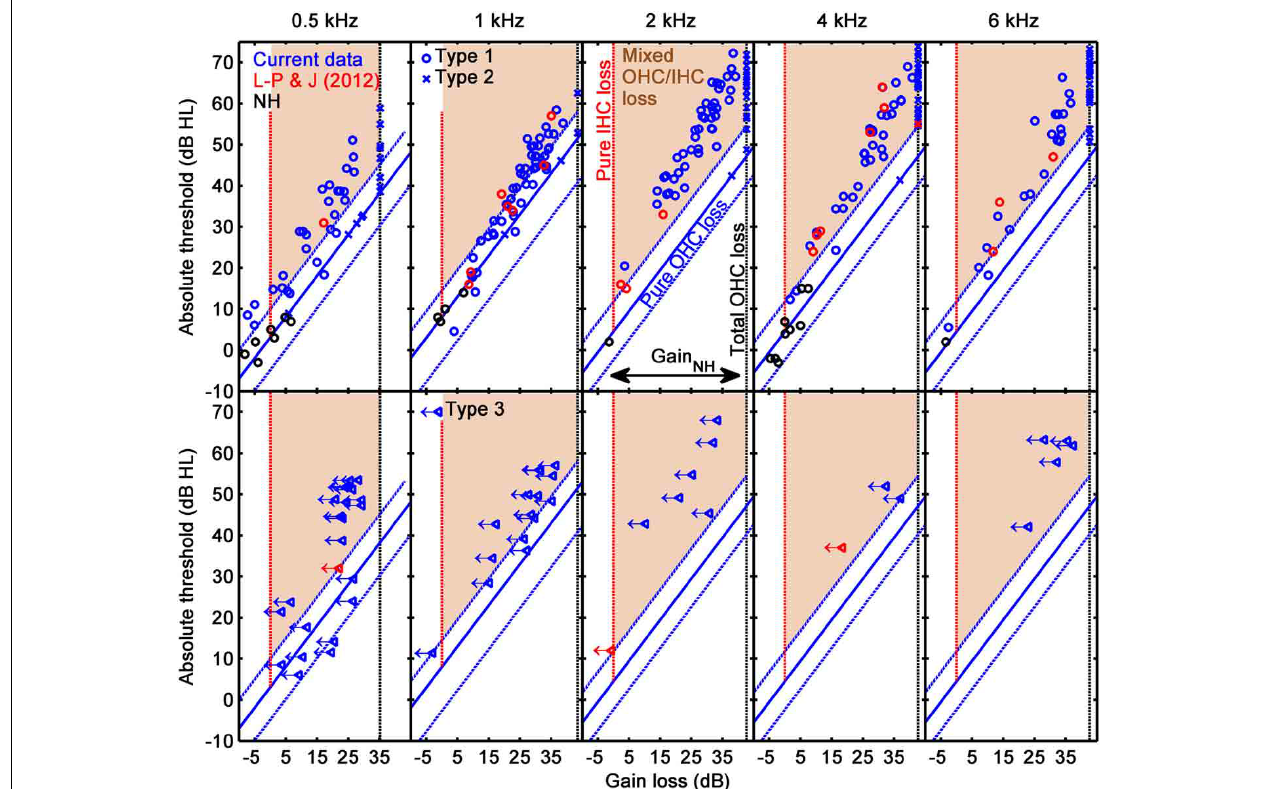
gain loss, as inferred from the I/O curves of the reference, NH sample (black circles) (Johannesen and Lopez-Poveda, 2008). The red dotted lines depict the hypothetical location of cases with pure IHC loss (i.e., hearing loss with zero HL OHC ). The shaded areas indicate mixed OHC/IHC losses. Results for the current listeners are depicted as blue symbols; results for NH listeners and for listeners with mild-to-moderate loss from our earlier study (Lopez-Poveda and Johannesen, 2012) are depicted as black and red symbols,